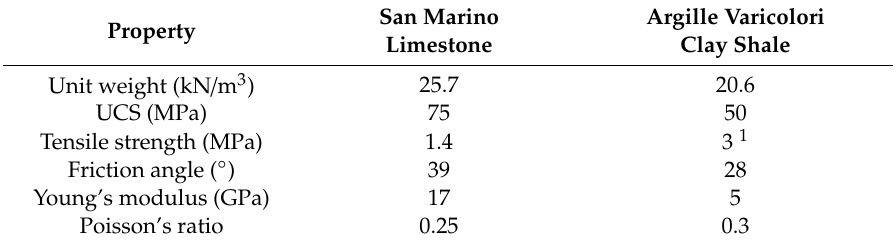
Table 5. Intact material properties assumed for the numerical modelling of the San Leo landslide in Slope